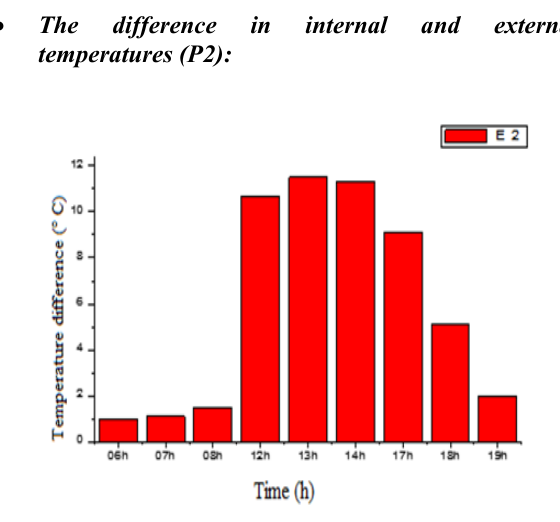
Figure 12. Internal, external temperatures